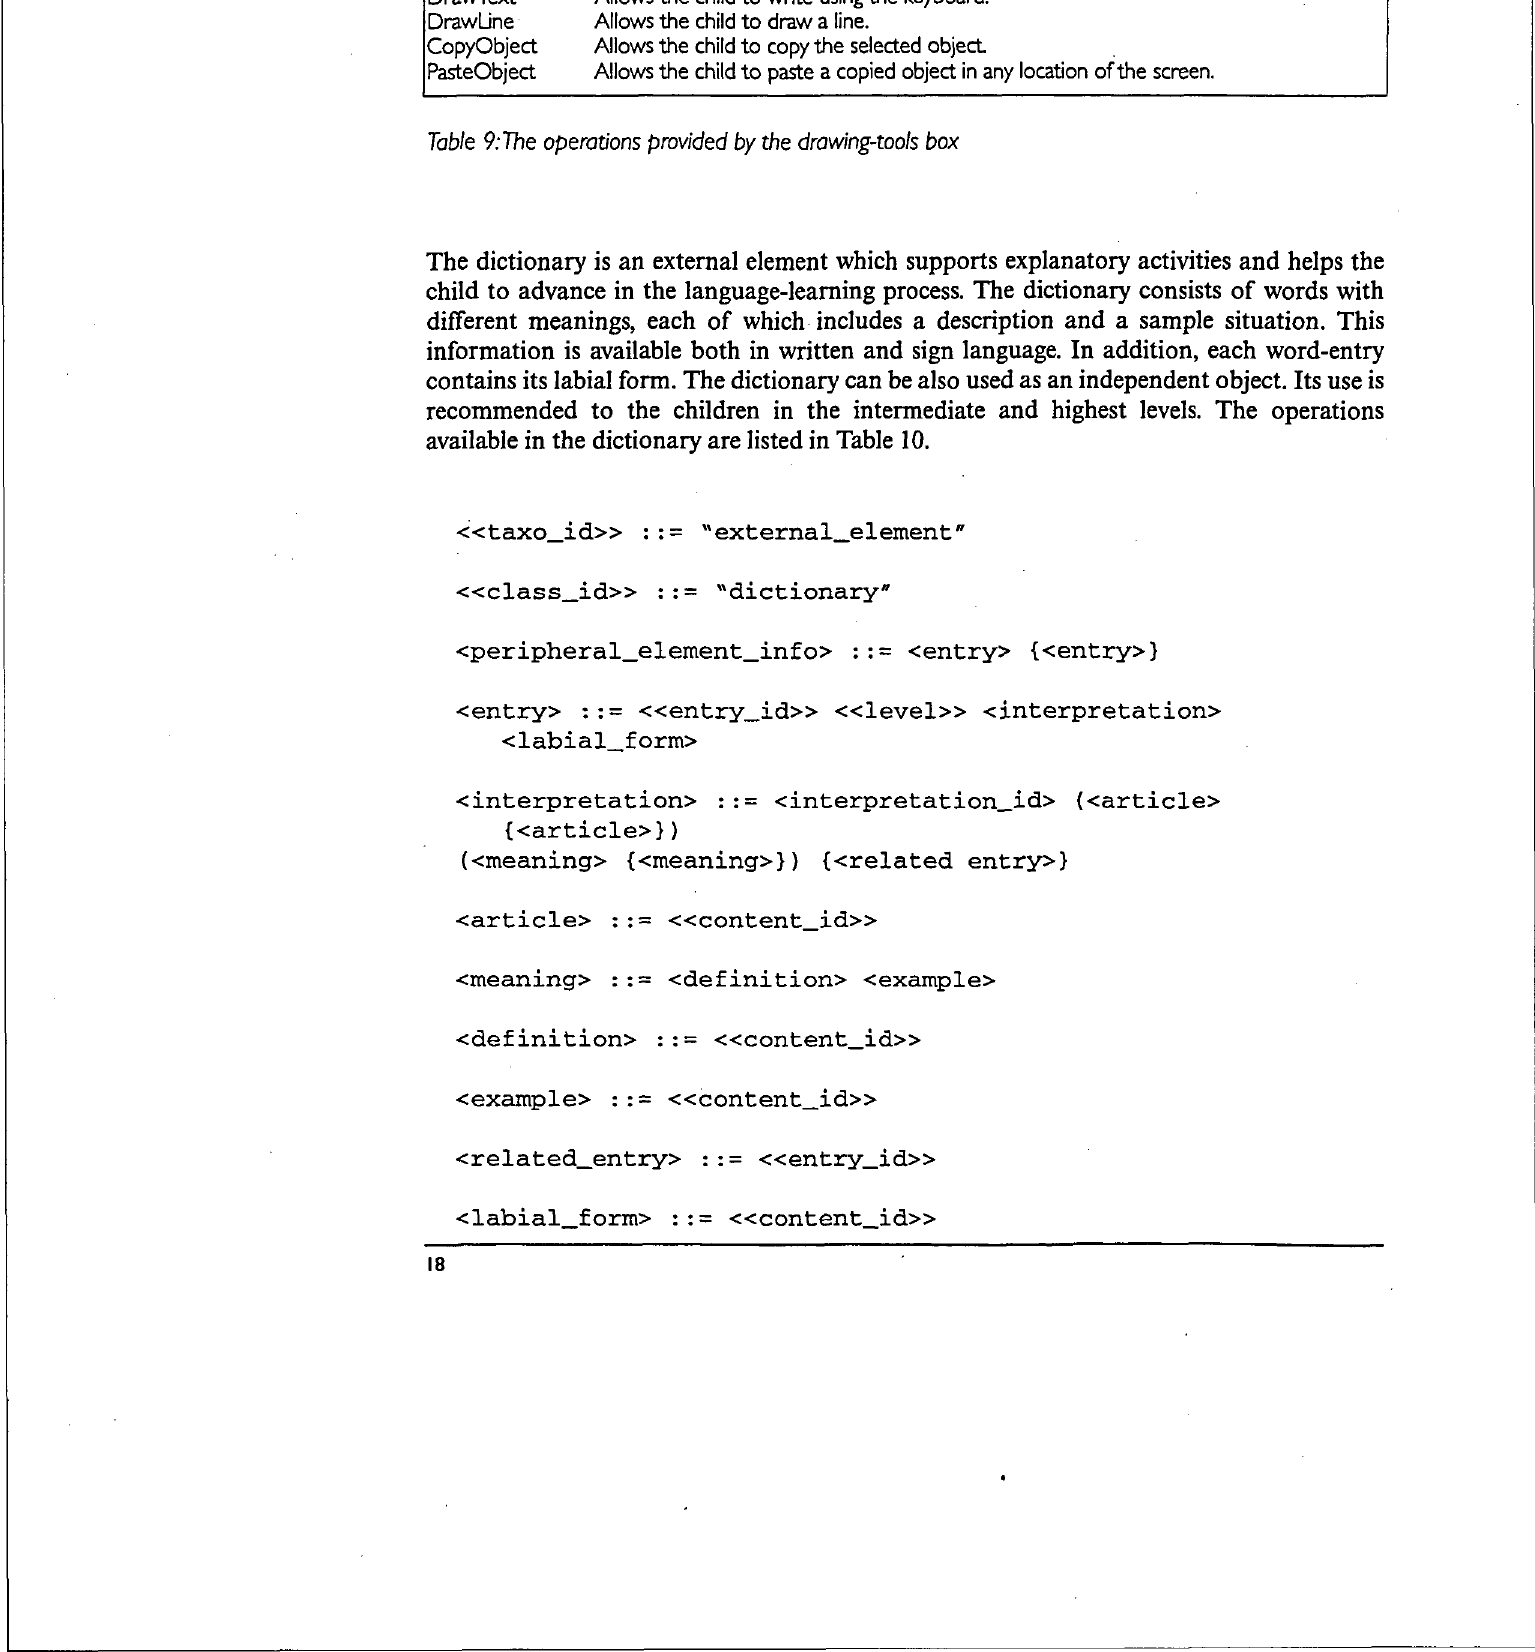
Table 9:The operations provided by the drawing-tools box